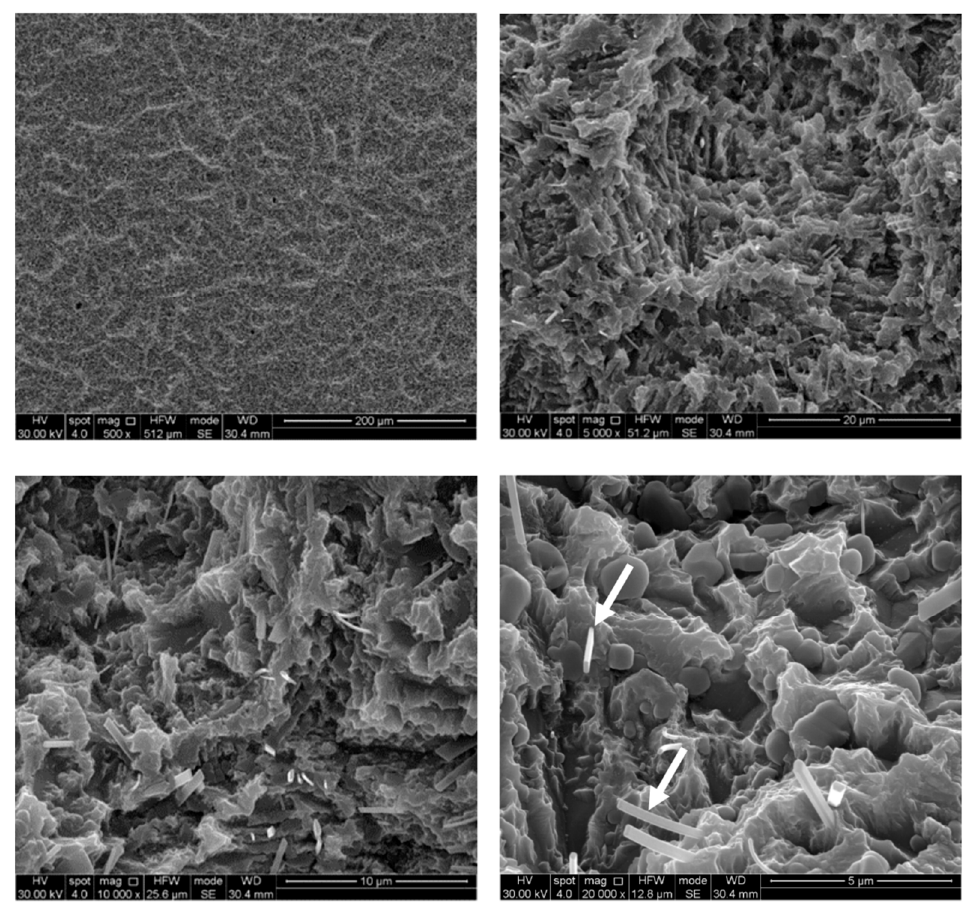
Figure 3. SEM images of air powder abrasion (AP) samples. Glycine particle residues (white arrows) and rounded edges can be observed. Magnifications from 500× to 20,000×.